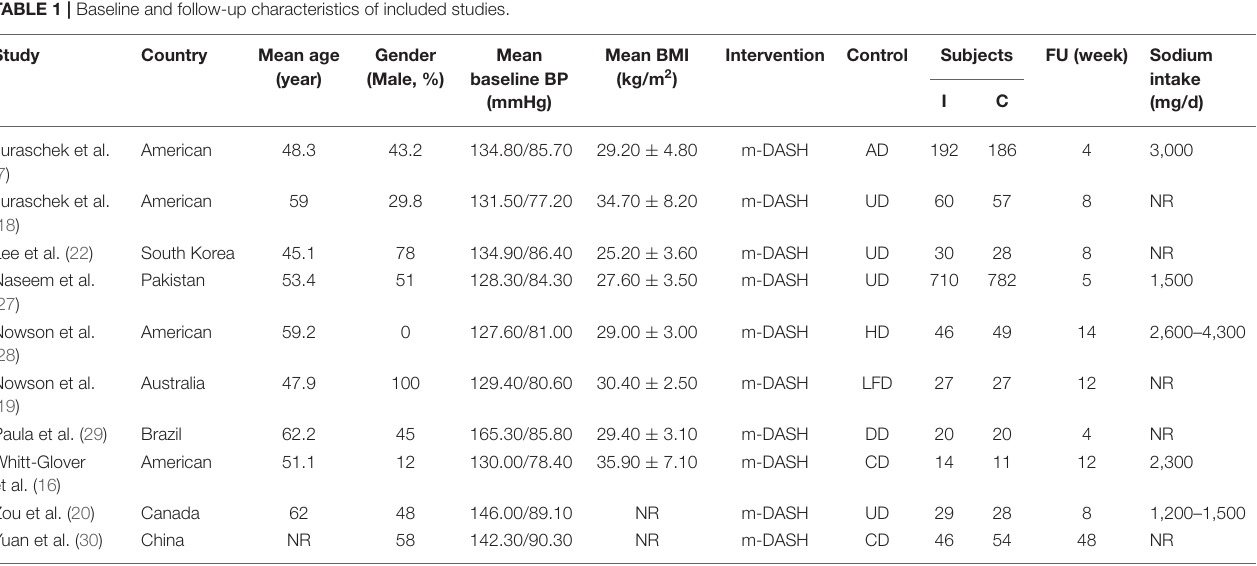
TABLE 1 | Baseline and follow-up characteristics of included